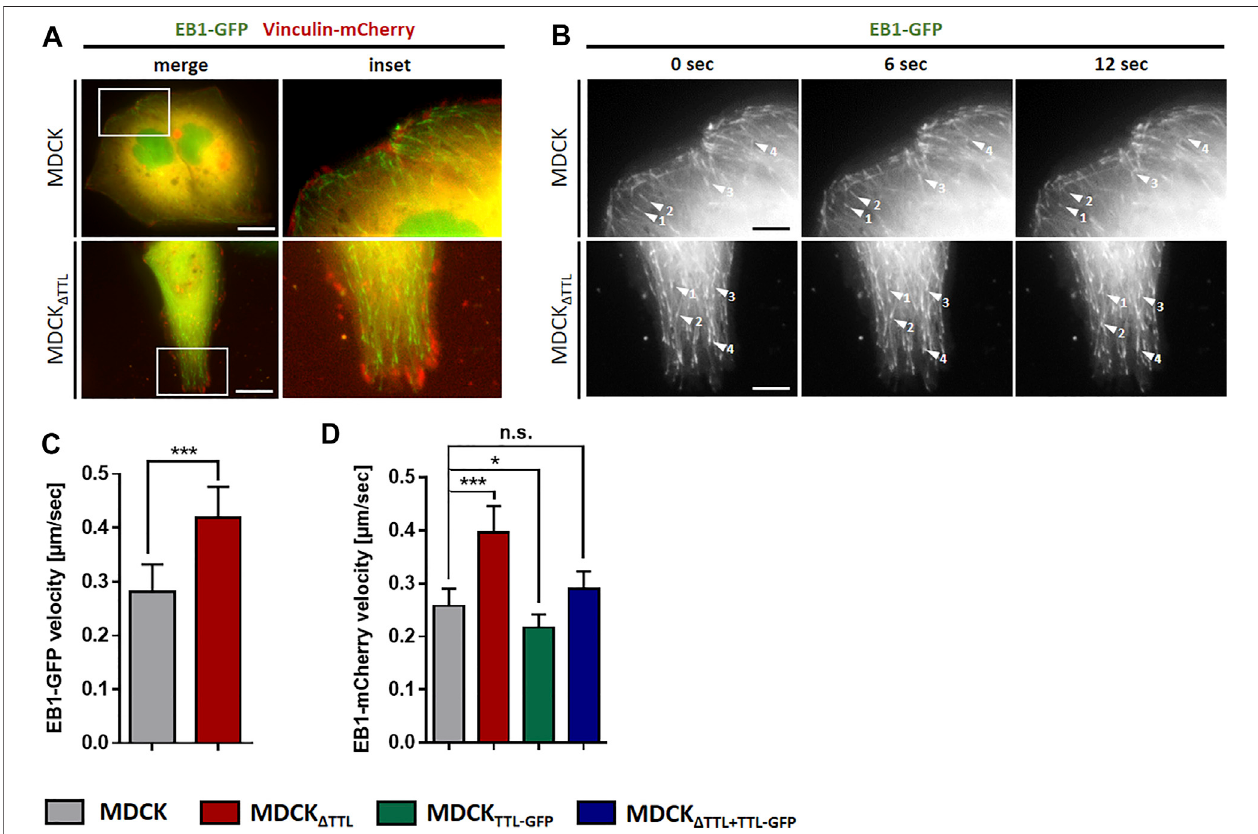
FIGURE4| DynamicsofEB1inMDCK cells. (A) Subcon fl uentlivingMDCK andMDCK Δ TTL cellstransientlytransfectedwithEB1-GFP/vinculin-mCherryincubated on glass bottom WillCo dishes under a humidi fi ed atmosphere of 5% CO 2 in air. Dynamics of EB1-GFP (green) was analyzed by fl uorescence microscopy at 37 ° C. Vinculin-mCherry (red) indicates focal adhesions. Scale bars: 10 µm. (B) EB1-GFP dynamics was observed in MDCK and MDCK Δ TTL cells. Time-lapse imaging was recorded over 12 sec. Each arrowhead indicates EB1-GFP comet-like accumulation, tracked for indicated time intervals. Scale bars 2 µm. (C) Quanti fi cation of EB1-GFP velocities in MDCK and MDCK Δ TTL cells. Experiments were quanti fi ed with the Imaris Cell Imaging Software. Mean ± s.d., n = 3. Statistical signi fi cance was tested with Student`s unpaired t -test (*** p < 0.001). (D) Quanti fi cation of EB1-mCherry velocites in MDCK, MDCK Δ TTL, MDCK TTL-GFP and MDCK Δ TTL+TTL-GFP cells, transfected with EB1-mCherry. Mean ± s.d., n = 3. Statistical signi fi cance was tested with Student`s unpaired t -test (n.s., not signi fi cant; * p < 0.05; *** p < 0.001).